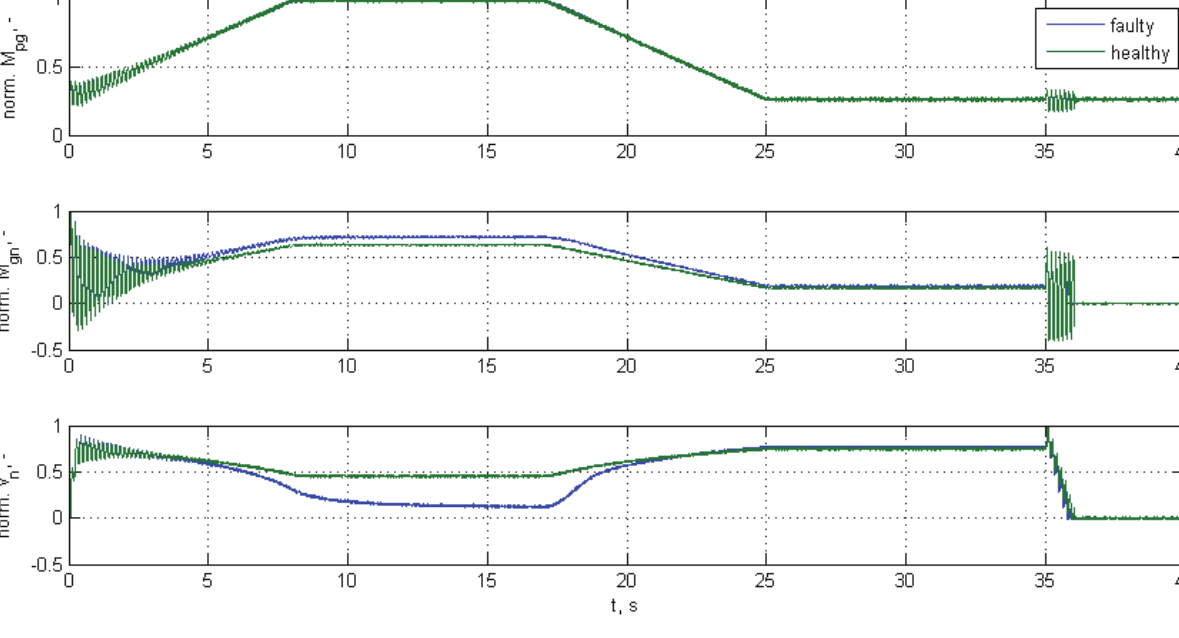
Fig. 11. Comparison of results of simulation following scenario S8 for healthy and faulty (U2) conditions